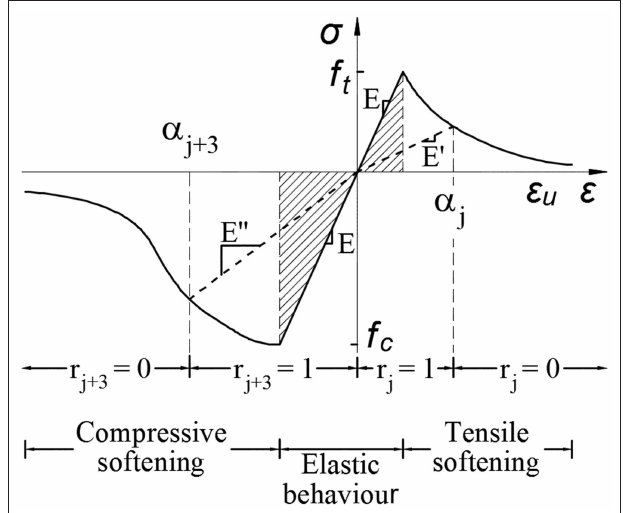
FIGURE 1 | Stress-strain diagrams